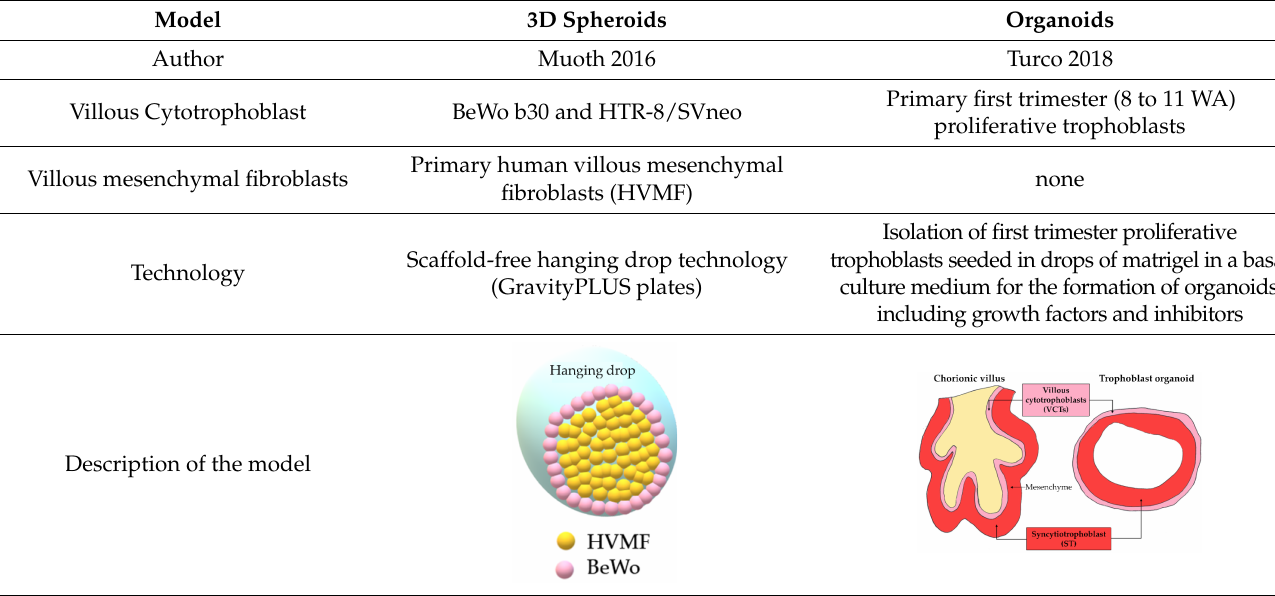
Table 3. 3D models (reproduced after Muoth et al. [66] and Turco et al.